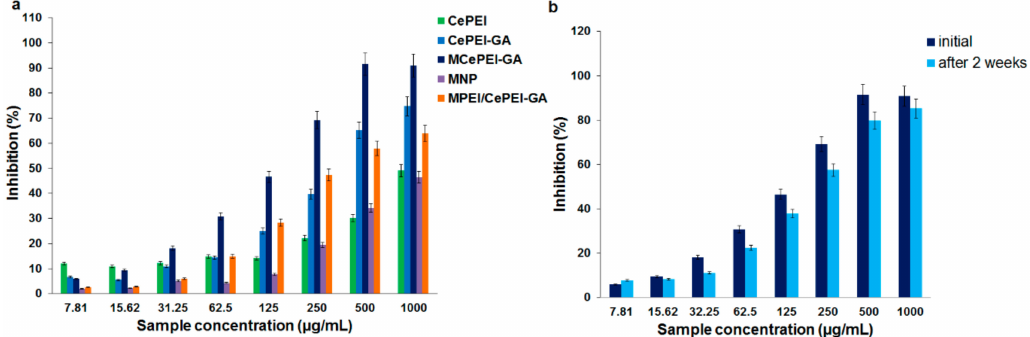
Figure 7. Antioxidant activity against 1,1-diphenyl-2-picryhydrazyl (DPPH) of: ( a ) CePEI, CePEI-GA, MCePEI-GA, MNP and MPEI / CePEI-GA samples; ( b ) MCePEI-GA over